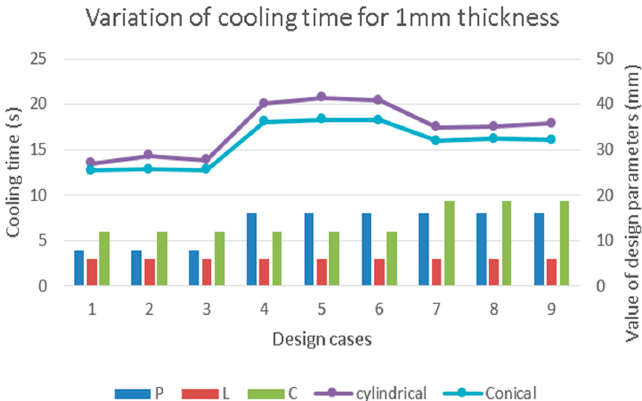
Figure 7. Cooling time variation for one-mm thick plastic parts (both cylindrical and conical).